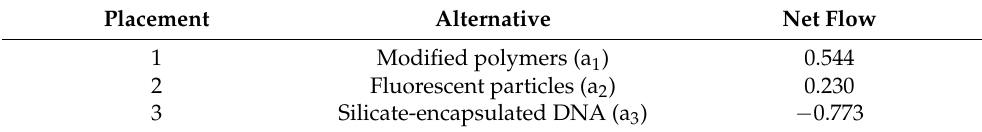
Table 8. Ranking of the studied alternatives.